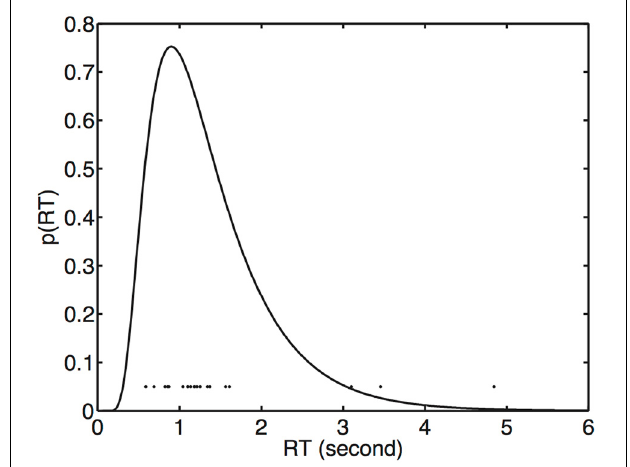
FIGURE 3 | Reaction times fitted with an inverse Gaussian (Equation 15). Each dot represents 1 of 20 RTs for a stimulus value (width scaling) of s = 1 .